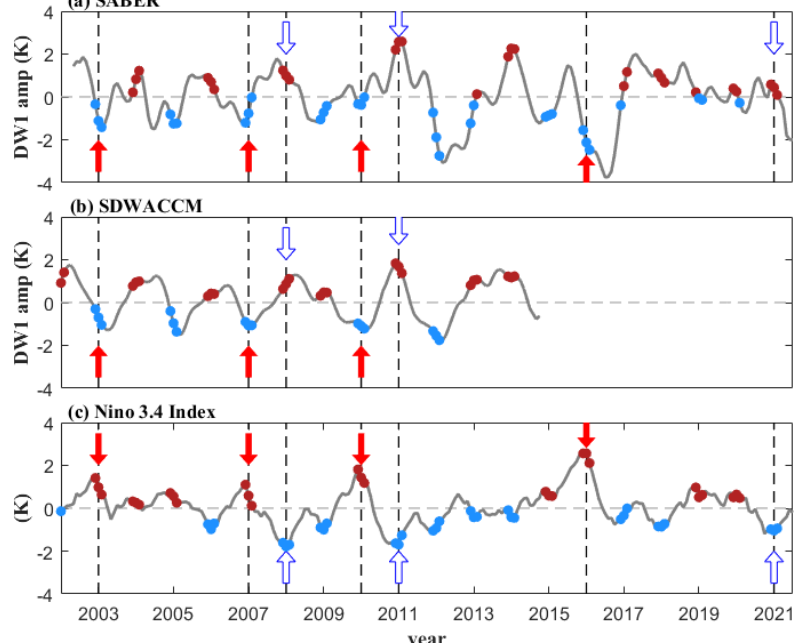
Figure 2. (a) The residual DW1 temperature amplitude of SABER observations averaged over 10 ◦ S–10 ◦ N at 100km from 2002 to 2021. (b) Same as in (a) but for SD-WACCM. (c) Niño3.4 index. Dashed lines represent ENSO events. The red solid and hollow blue arrows denote the El Niño and La Niña